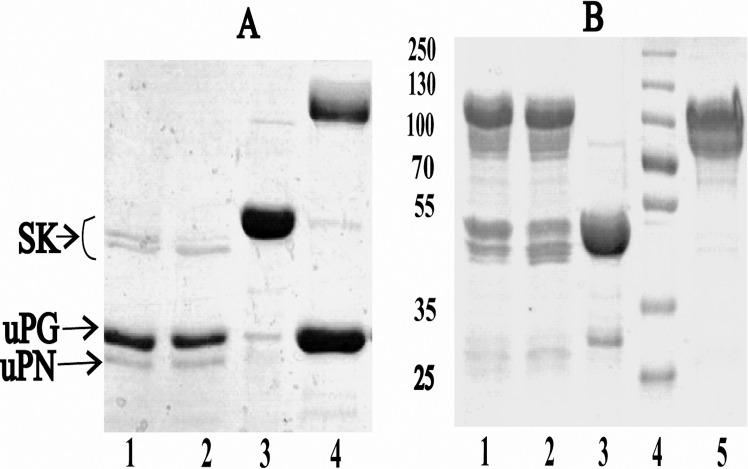
SDS-PAGE analysis of the HPG/μPG-nSK/PEG-SK complexes.Native SK/PEG-SK was incubated with HPG/μPG to form 1:1 complex at 5 μM concentration. After 3 and 10 min, each of these complexes were subjected to SDS-PAGE under reducing conditions. (A) Gel demonstrates the fragmentation of nSK after complex formation with μPG while no effect was noticed with PEG-SK derivatives. Lane 1: nSK-μPG complex (3 min); lane 2: nSK-μPG complex (10 min); lane 3: Streptokinase alone; lane 4: SK1-383N-PEG20-μPG (10 min). (B) SDS-PAGE indicates the blockage of pathway I when in complex with HPG. Lane 1: nSK-HPG complex (3 min); lane 2: nSK-HPG complex (10 min); lane 3: Streptokinase alone; lane 4: Molecular weight marker; lane 5: SK1-383N-PEG20-HPG (10 min).